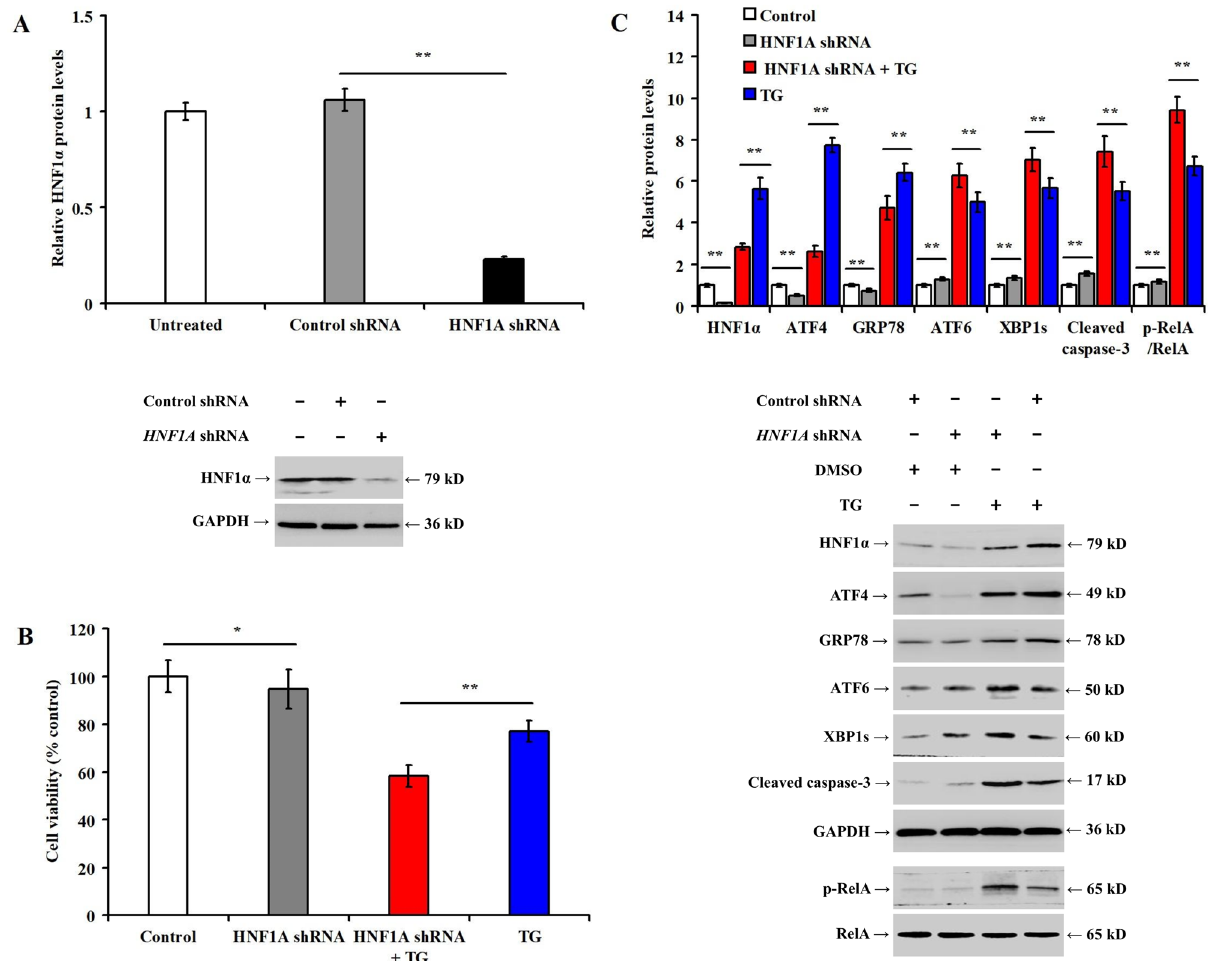
Figure 2. Knockdown of HNF1A aggravates apoptosis and reduces ATF4 and GRP78 expression during ER stress in LO2 cells. LO2 cells were pretreated with control shRNA or HNF1A shRNA for 48 h, then incubated with DMSO or TG (1.0 μmol/L) for 36 h: ( A ) bar chart and representative western blotting showing the alteration of HNF1α expression after HNF1A shRNA transfection; ( B ) bar chart representing MTS cell viability among the different experimental groups in LO2 cells; and ( C ) bar chart representing the relative protein expression and representative Western blotting for the different experimental groups. * p < 0.05, ** p < 0.01, versus the control group (control shRNA, or control shRNA + DMSO) or TG group (control shRNA + TG).